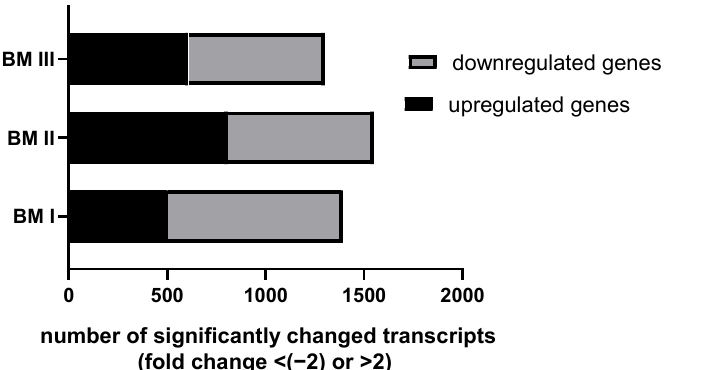
Figure 6. The transcriptome of PT and BM I–III was analyzed and up or downregulation of transcripts BM sublines compared to PT were calculated.